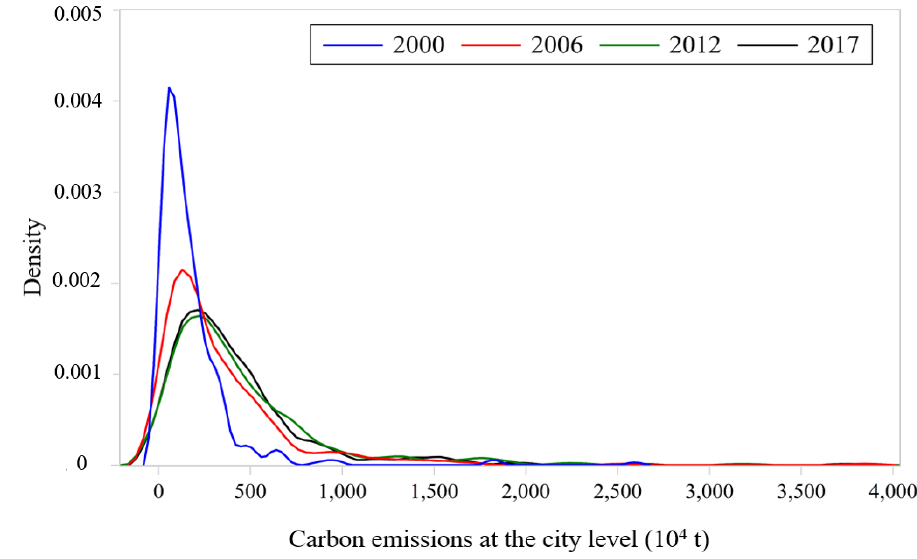
Figure 7. Kernel densities of carbon emissions at the city level for the periods 2000 – 2017.